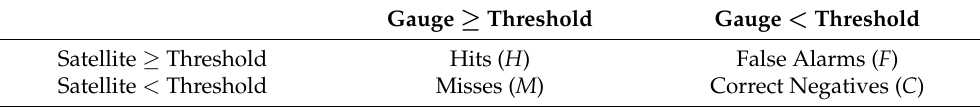
Table 1. Contingency table of gauge and satellite precipitation